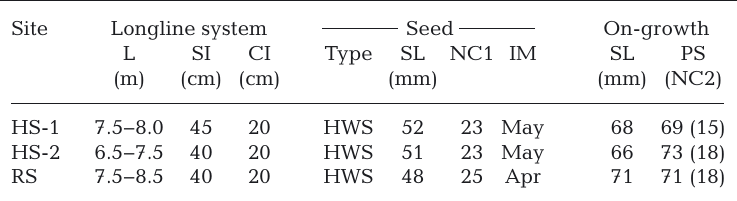
Table 1. Longline system and Crassostrea gigas growth performance before hypoxia. On-growth data were measured 7 to 10 d before the hypoxia event; percentage survival (PS) and number of on-growing oysters on the clutch (NC2) were calculated based on number of seed oysters on the clutch (NC1), in which oysters detached from the collectors were considered to be dead. L: suspension line length; SI: suspension line interval on longline; CI: clutch interval on the suspension line; SL: shell length; IM: installation month; HWS: hardened wild seed; HS-1: Hypoxic Site 1 in Goseong Bay; HS-2: Hypoxic Site 2 in Buksin Bay; RS: reference site. Data courtesy of local governments: HS-1 from Goseong County, HS-2, and RS from Tongyeong City,